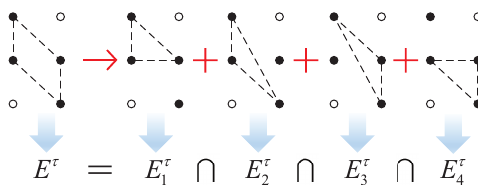
Figure 5. The divided three-legged support states of the four-legged support